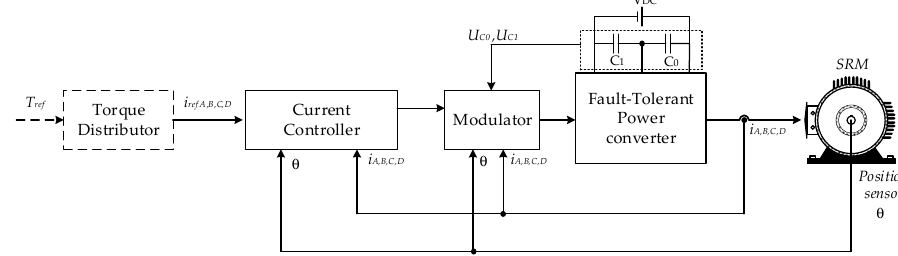
Figure 7. Simplified block diagram of the SRM speed controller.